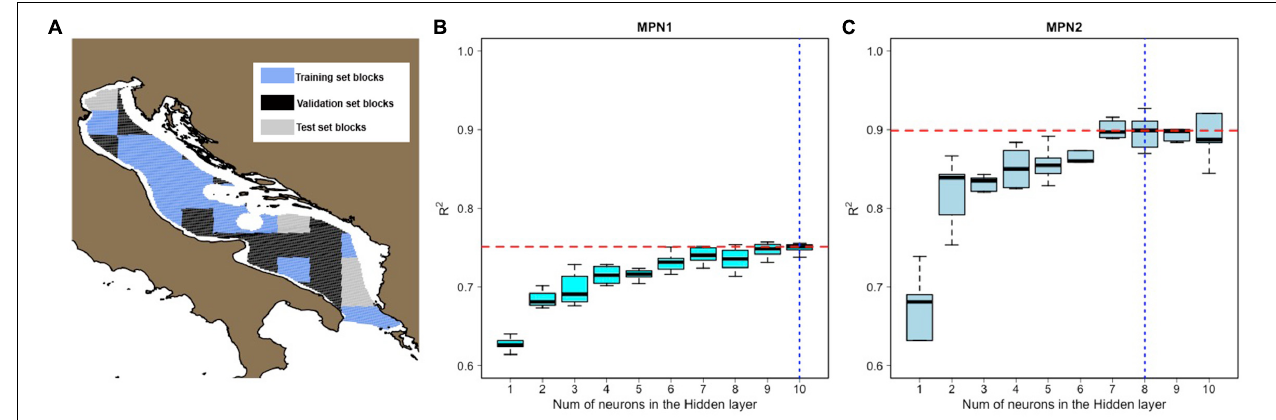
FIGURE 7 | (A) Example of the random definition of blocks for the training, validation and test datasets. Performance (measured as R 2 values between the predicted and observed values of the fishing effort in the test dataset) of MPN1 (B) and MPN2 (C) with different numbers of neurons in the hidden stratum. The entire training and test procedure, including random partitioning of data in training and test sets, was replicated 10 times for each value of the number of neurons in the hidden stratum. For MPN2, the distributions in the boxplots represent the aggregation of the four MPN2s (one for each length class). The dashed blue lines in (B) and (C) indicate the selected values of the number of neurons in the hidden stratum. The dashed red lines in (B) and (C) provide the corresponding median R 2 values for MPN1 and MPN2 with the selected values of the number of neurons in the hidden stratum.